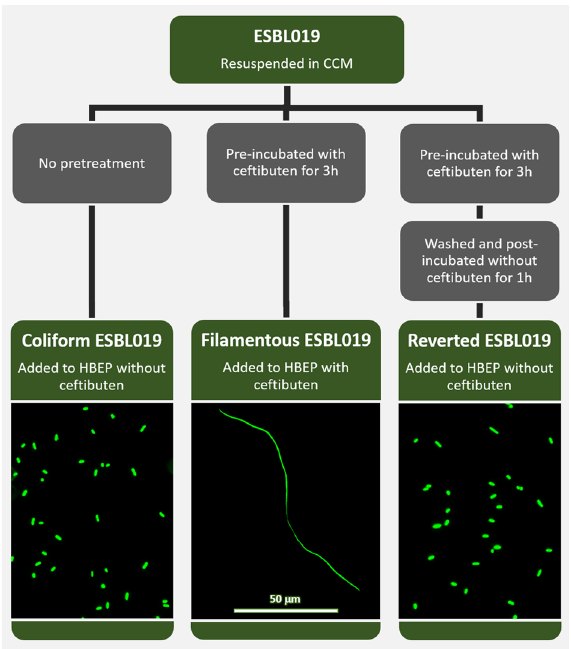
Figure 1. Summary of the experimental protocol and a visual demonstration of the three different morphological states of ESBL019. ESBL019 Coliform was grown for 3 h in cell culture medium (CCM) without ceftibuten, ESBL019 Filamentous was grown for 3 h in the presence of ceftibuten and ESBL019 Reverted was grown in the presence of ceftibuten for 3 h and then without ceftibuten for 1 h to allow its reversion. The bacteria were thereafter added to HBEP cells, in 6-well plates, in the presence or absence of ceftibuten as indicated. The lower panel demonstrates the different morphological states of ESBL019 carrying an eGFP- plasmid (enhanced green fluorescence protein, kindly provided by Professor Philip Poole at University of Oxford, UK). Scale bar: 50